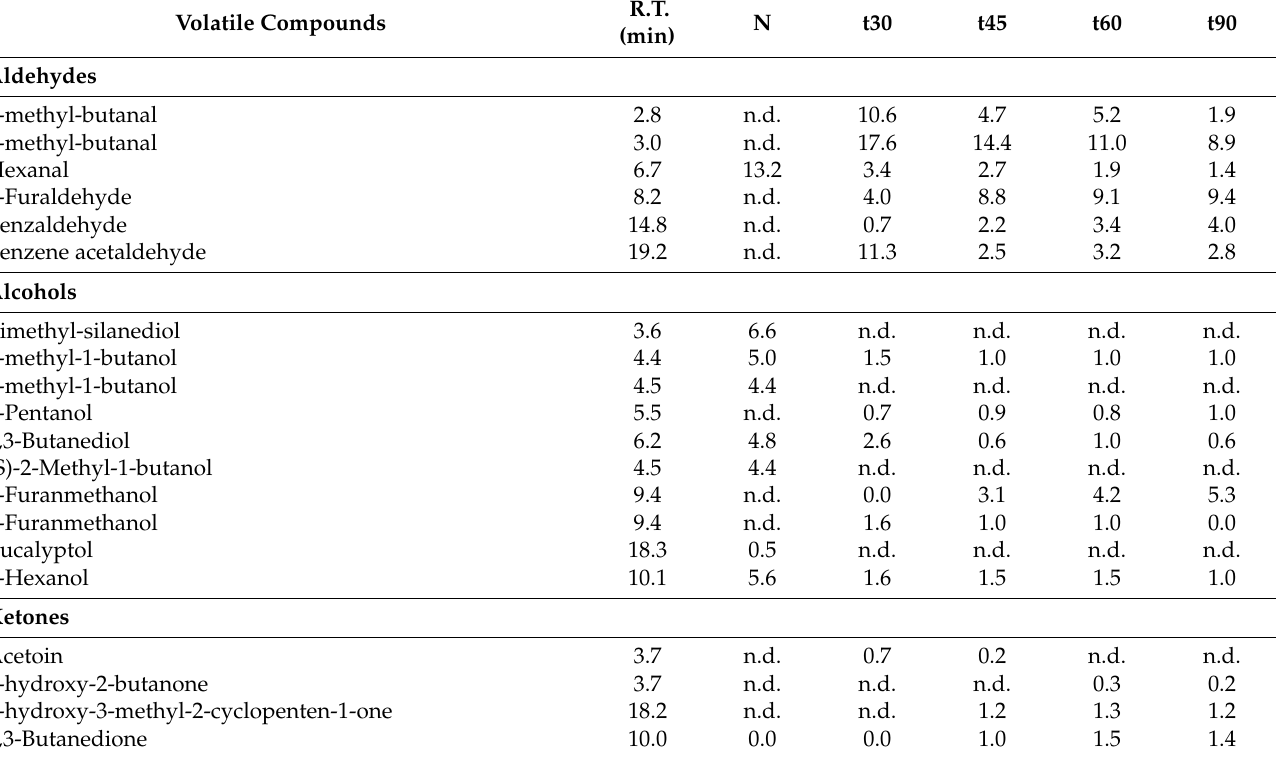
Table 2. Content of volatile compounds (mean %, n = 3) obtained from oils extracted from almond seeds subjected to different thermal treatments before oil extraction. R.T.: retention